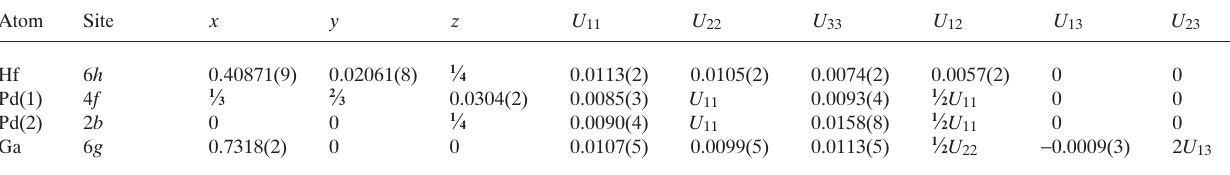
Table 2. Atomic coordinates and displacement parameters (in Å 2 ) .